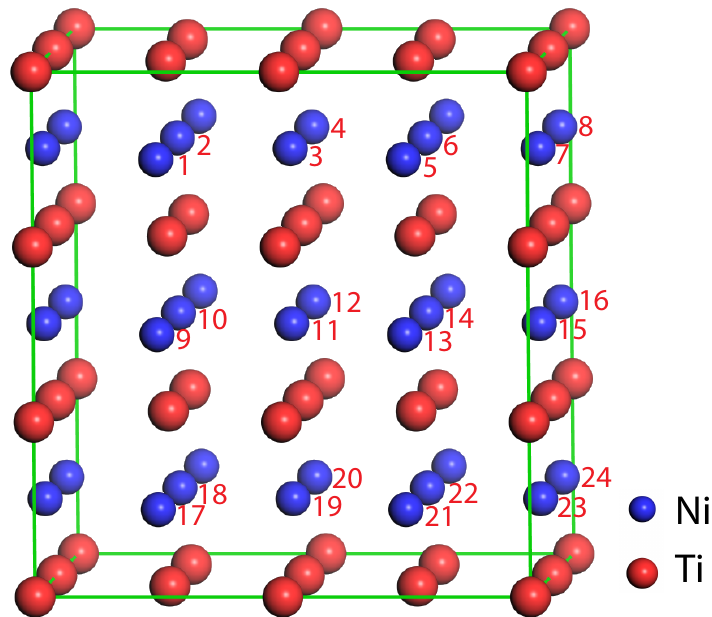
Figure 1. Ni occupancy in the austenite B2 3 × 2 × 2 supercell Ni 24 Ti 24 structure. Smaller blue spheres denote Ni atoms; larger gray spheres denote Ti atoms. The 3 × 2 × 2 supercells of B19 and B19 (cid:48) are also used, and structures are similar to that of